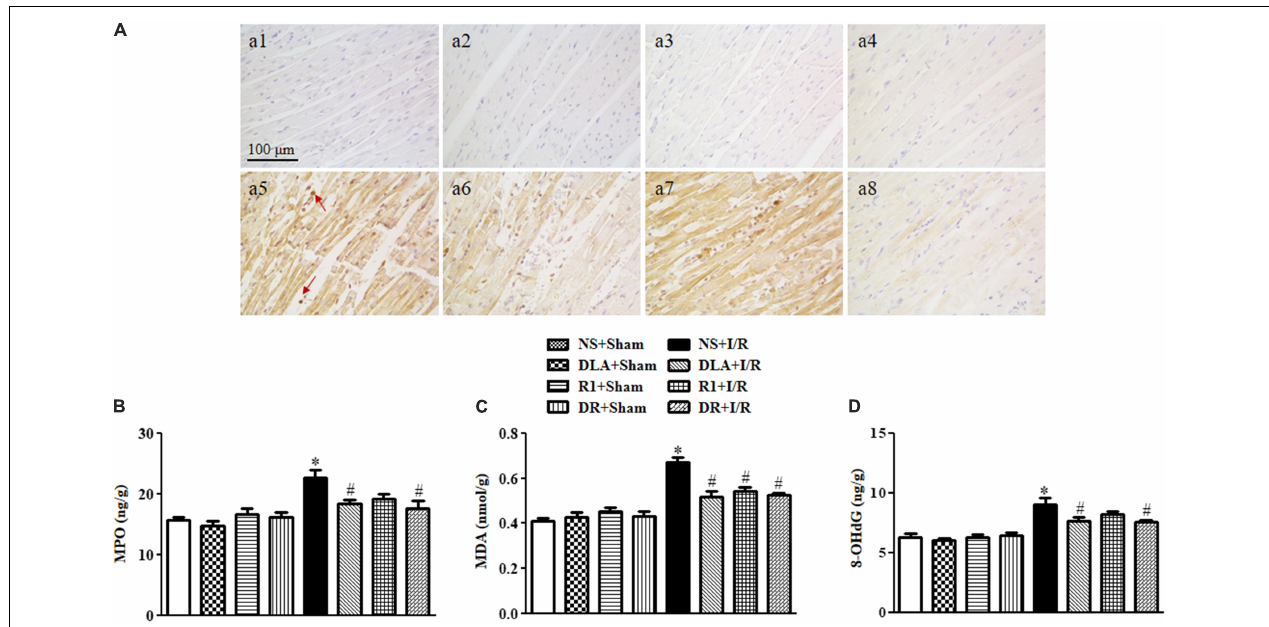
FIGURE 7 | The effect of DLA, R1, and DR pretreatment on myeloperoxidase (MPO), malondialdehyde (MDA), and 8-oxo-deoxyguanosine (8-OHdG) level in the myocardial tissue of rats after I/R for 90 min. (A) Representative photographs of immunohistochemistry staining for MPO of myocardium in the NS + Sham group (a1) , the DLA + Sham group (a2) , the R1 + Sham group (a3) , the DR + Sham group (a4) , the NS + I/R group (a5) , the DLA + I/R group (a6) , the R1 + I/R group (a7), and the DR + I/R group (a8) . Bar = 100 µ m. Arrows indicate MPO-positive cells. (B) Quantitative analysis of the MPO level by ELISA in rat myocardium in different groups ( n = 6). (C) Quantitative analysis of the MDA level by ELISA in rat myocardium in different groups ( n = 6). (D) Quantitative analysis of the 8-OHdG level by ELISA in rat myocardium in different groups ( n = 6). Data are expressed as means ± SEM (n = 6). * p < 0.05 vs. NS + Sham group; # p < 0.05 vs. NS + I/R